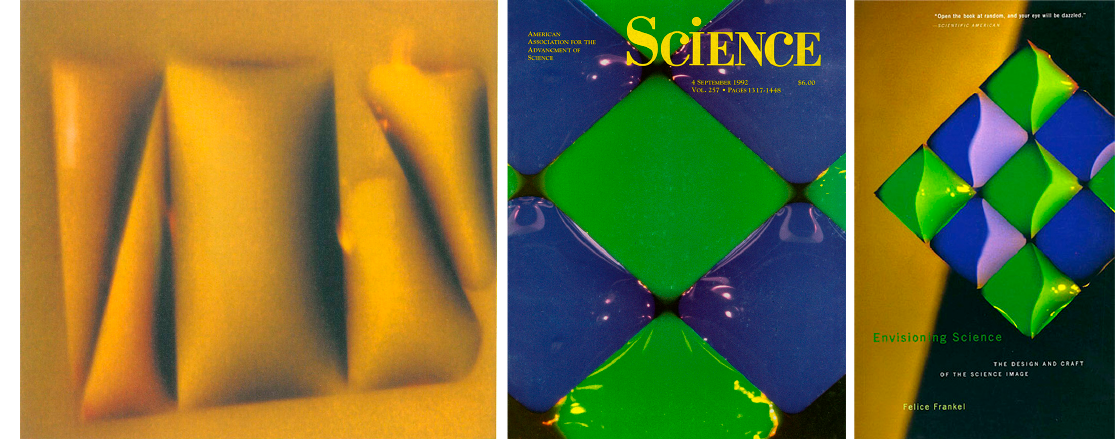
Figure 7. Original photo by the chemist Georges Whitesides and successive elaborations by the photographer Felice Frankel [17] (cover), [18] (pp.